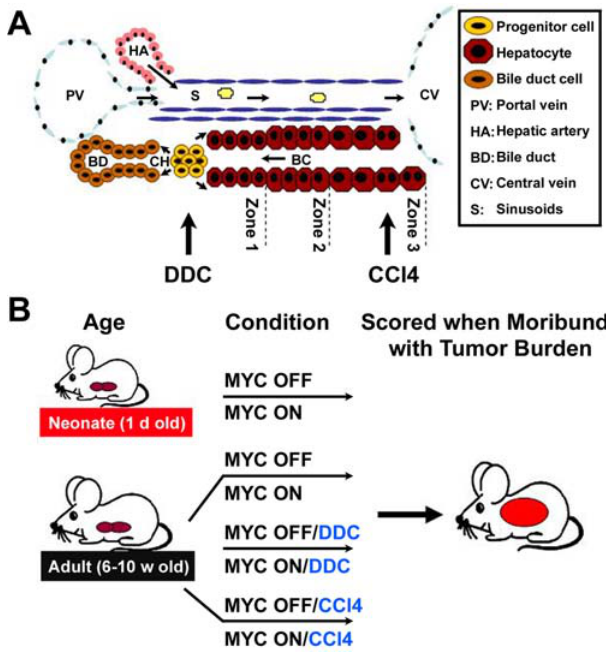
Figure 1. Examining the Impact of DDC and CCl 4 Damage on MYC-Induced HCC. (A) Schematic of the liver lobule illustrating that DDC causes liver damage associated with the emergence and proliferation of oval cells in the periportal area of the hepatic lobule, while CCl 4 causes damage associated with the destruction of hepatocytes near the central vein and triggers mature hepatocytes to proliferate. (B) Schematic of experimental design. Eight different cohorts of mice were monitored for tumorigenesis. MYC was activated (MYC ON) or kept inactive (MYC OFF) in mice: at birth, in 6–10 week old adult, in 6–10 w old adult mice treated with DDC, or in 6–10 w old adult mice treated with CCl 4 . Mice were sacrificed when moribund with tumor burden.